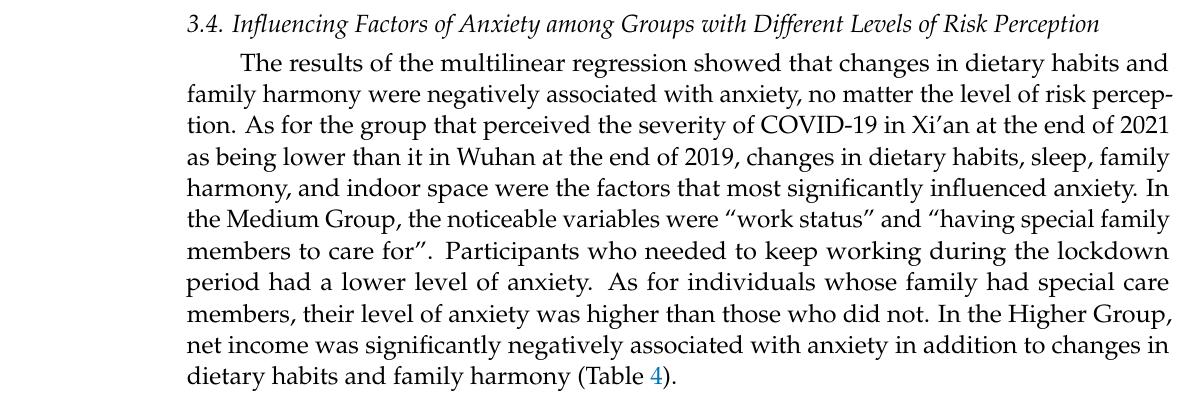
Table 4. Influencing factors of anxiety among risk perception